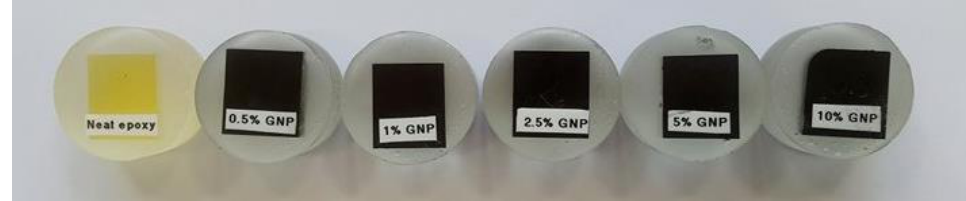
Figure 6. Micro-indentation tests.